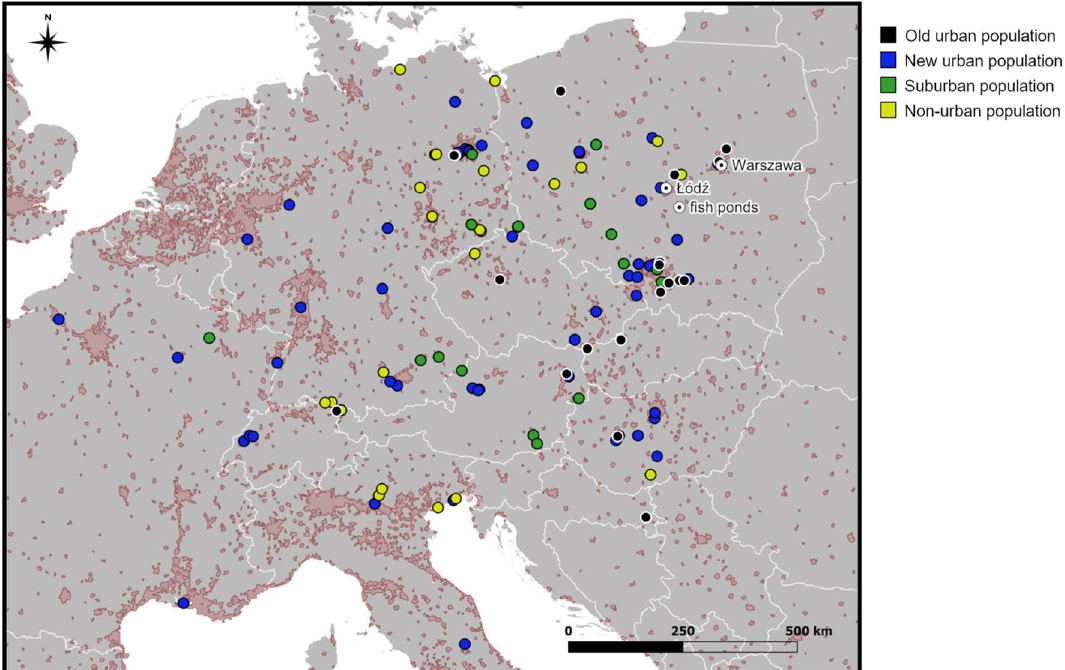
Figure 1. A map of non-breeding sites selected by Eurasian coots from different breeding populations in central Poland (old urban population—Warszawa; new and suburban populations—Łódź; non-urban population—fish ponds). A single non-breeding site (new urban population) in Spain was not shown because of outlying coordinates. The map was created in QGIS v. 3.16.0 (QGIS Development Team 2016, available at http:// qgis.osgeo .org) and edited in GIMP v. 2.10.10 (GIMP Development Team 2019, available at: http://gimp.org